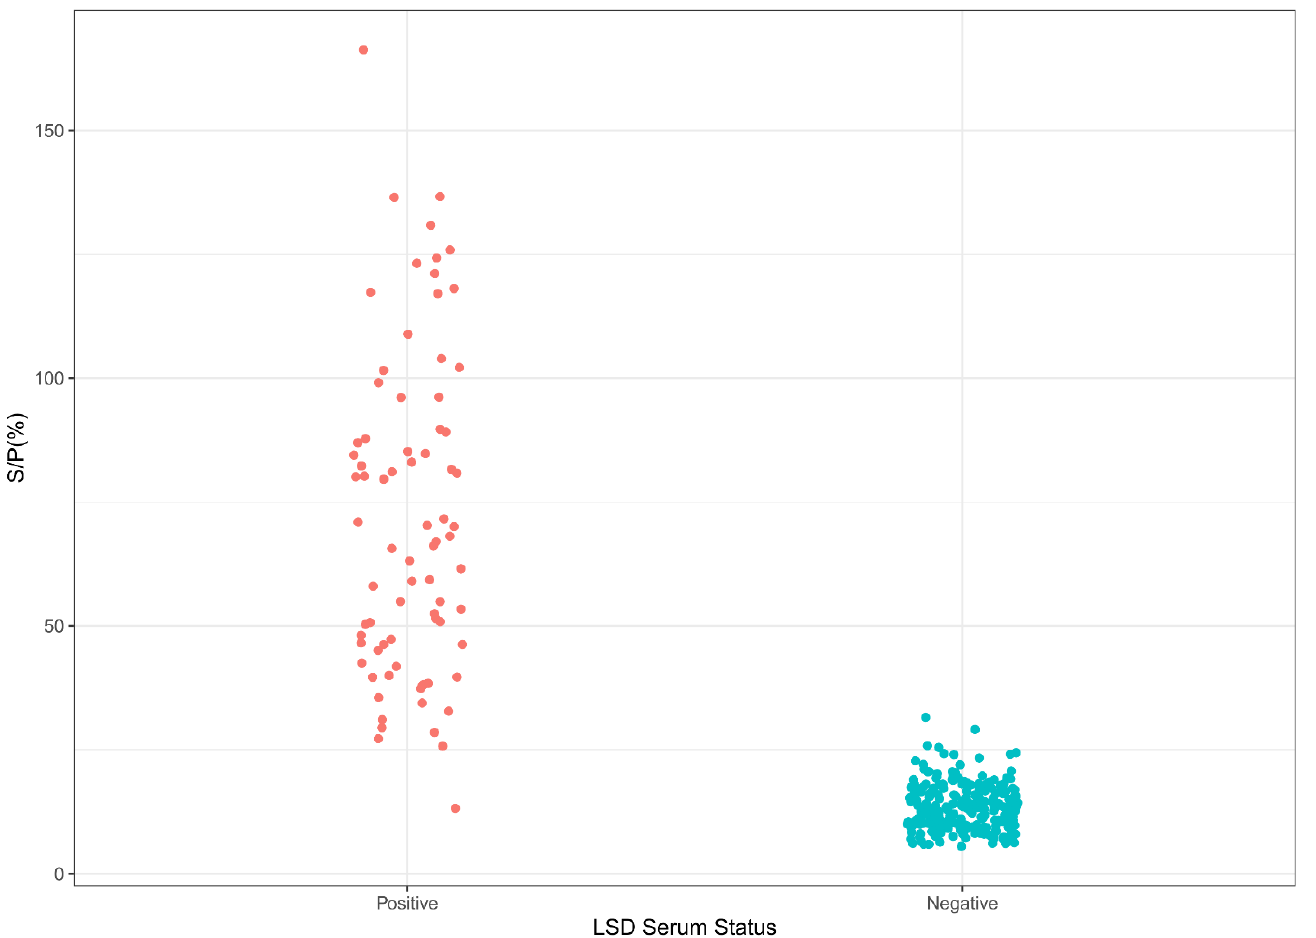
Figure 2. Sample distribution of the LSD iELISA. LSD-positive (78) and LSD-negative (252) serum samples were tested, using conditions for LSD iELISA.